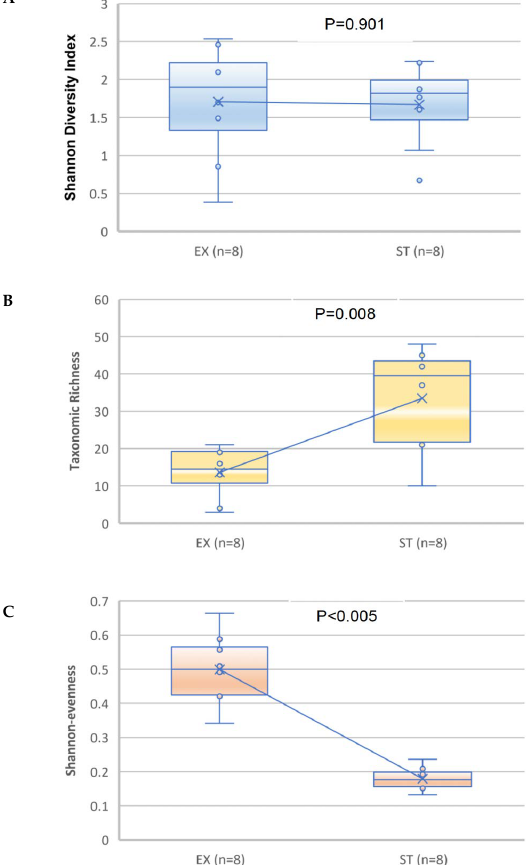
Figure 5. Comparison of the Shannon diversity ( A ), taxonomic richness ( B ), and Shannon evenness ( C ) of the bacterial microbiome for the sputum specimens from patients in the exacer- bation versus stable states. The paired Student’s t-test was used. The median is represented by a horizontal line inside each box, the interquartile range is indicated by the boxes and the range is denoted by the whiskers. The line is connecting the means of the two